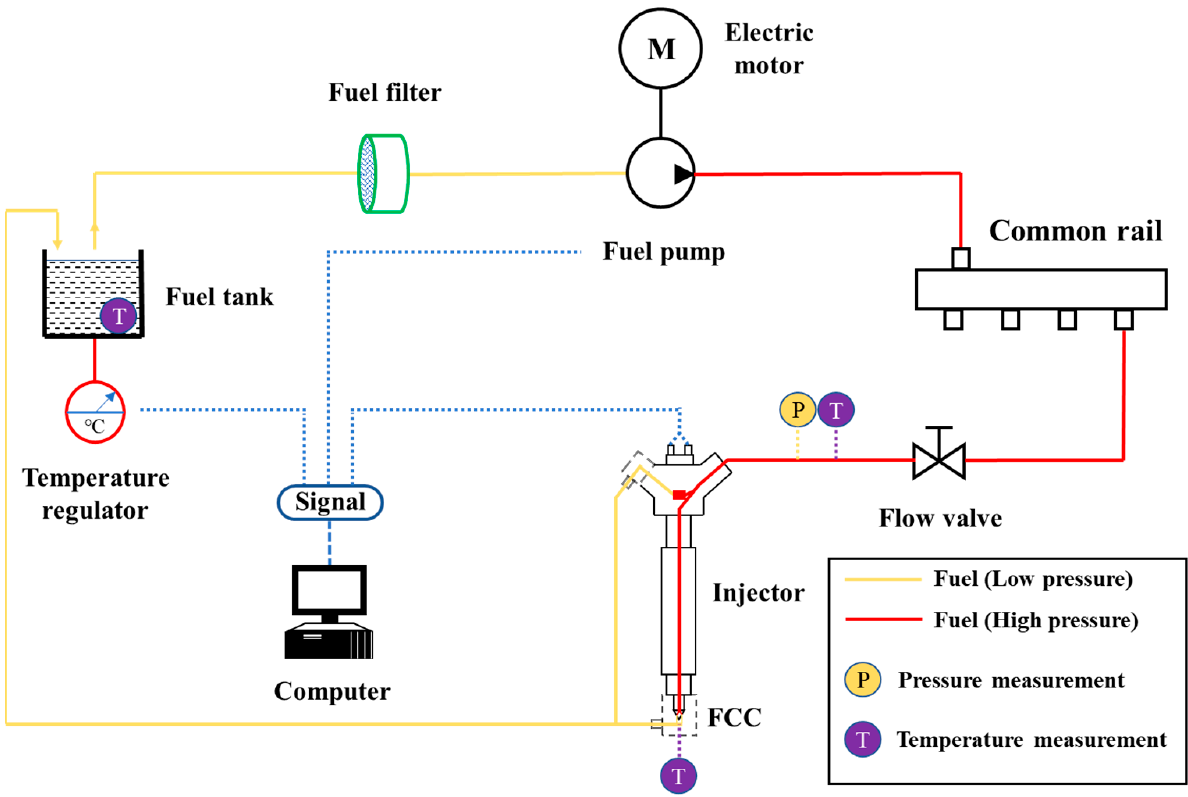
Figure 1. Experimental system for measuring the temperature increase in a CR injector.